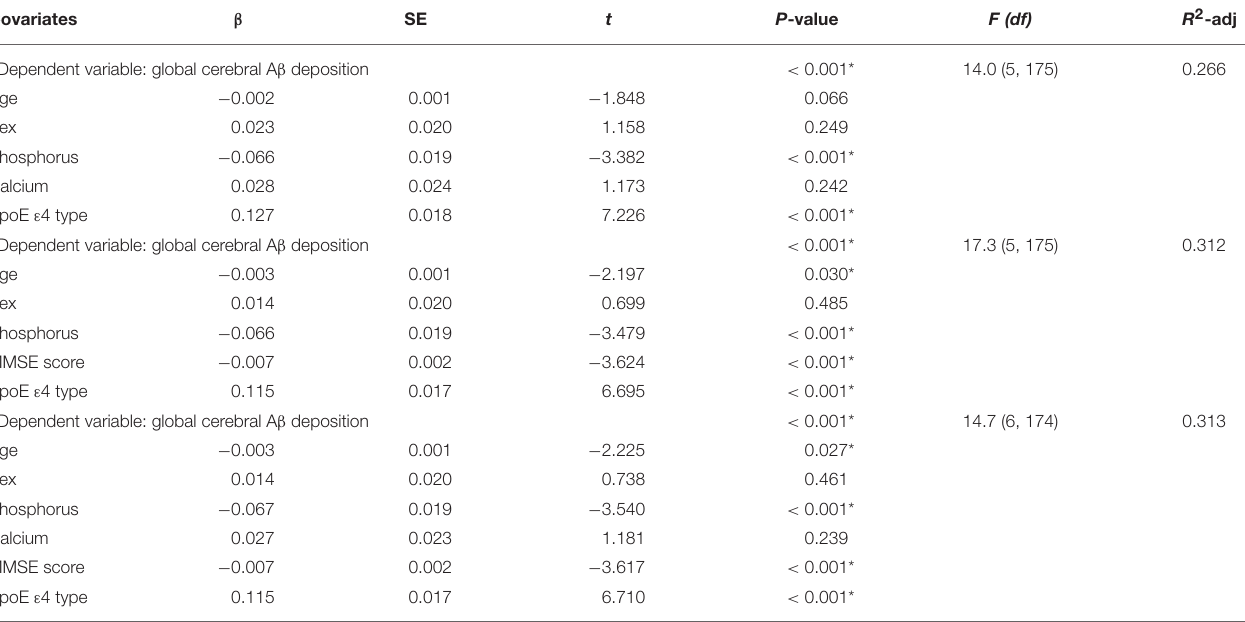
TABLE 4 | Multiple regression analyses of phosphorus, calcium, MMSE score, and ApoE ε 4 genotype with global cerebral A β deposition in cognitively impaired subjects.